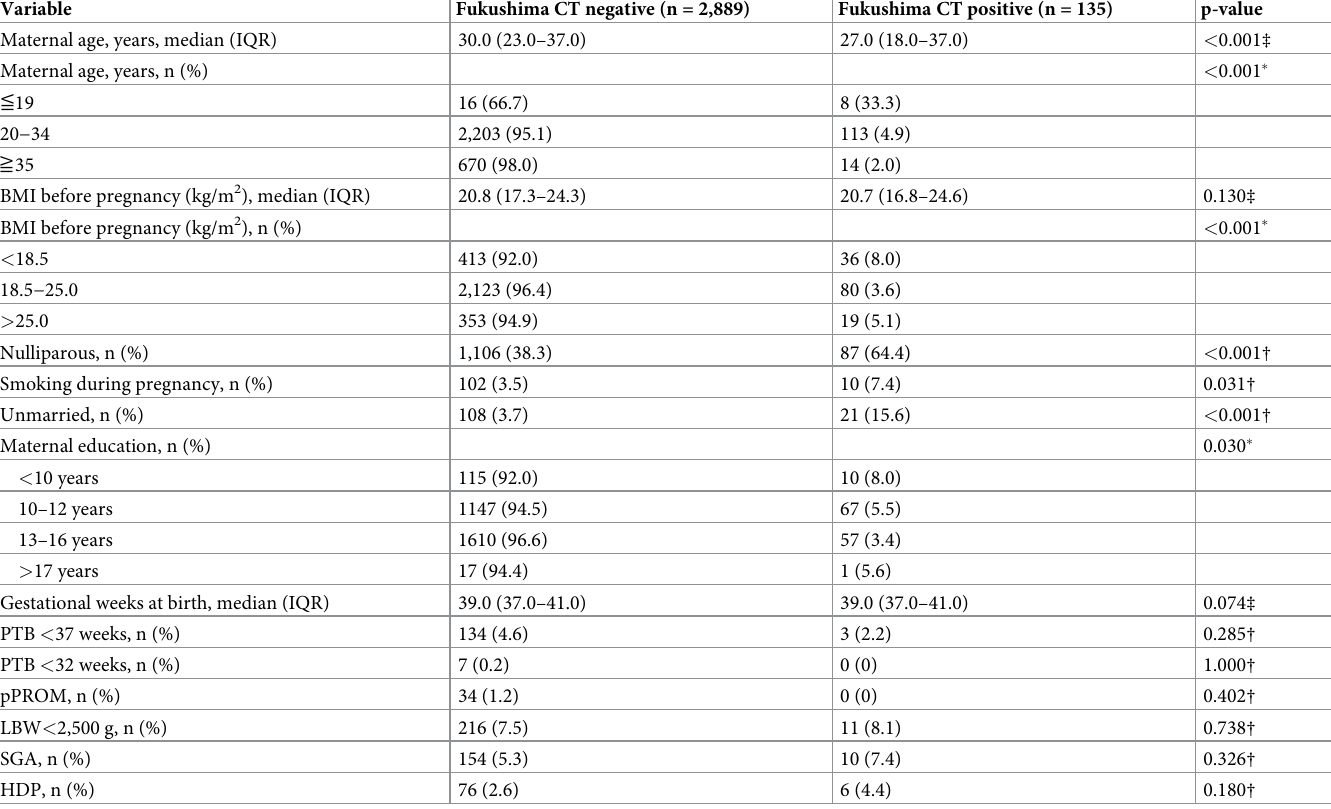
Table 2. Maternal medical and socioeconomic backgrounds and pregnancy outcomes (Fukushima participants).